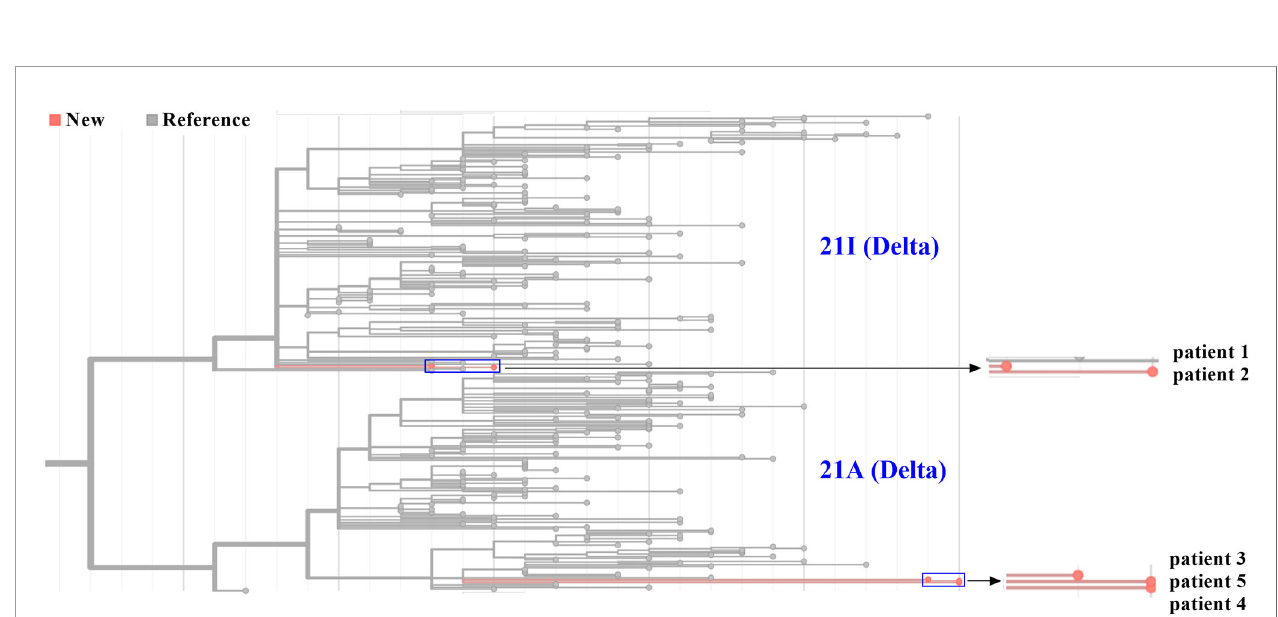
FIGURE 4 | Phylogenetic analysis of fi ve SARS-CoV-2 genomes from Zhengzhou. The phylogenetic tree was generated using Nextclade and visualized using Prism GraphPad 9. Line with red dots indicated our sequences, and line with gray dots indicated the reference sequences. By default, all sequences divided into 21A and 21I subclades in the Nextclade tool were displayed. The horizontal axis represented the number of mutations. The blue rectangle was zoomed in and displayed on the